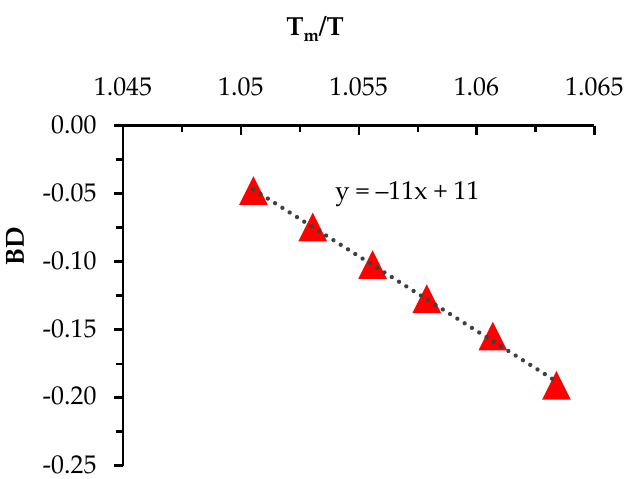
Figure 10. Analysis of the sintering activation energy within the pore dissolution model on the example of the II ‐ 5 sample.